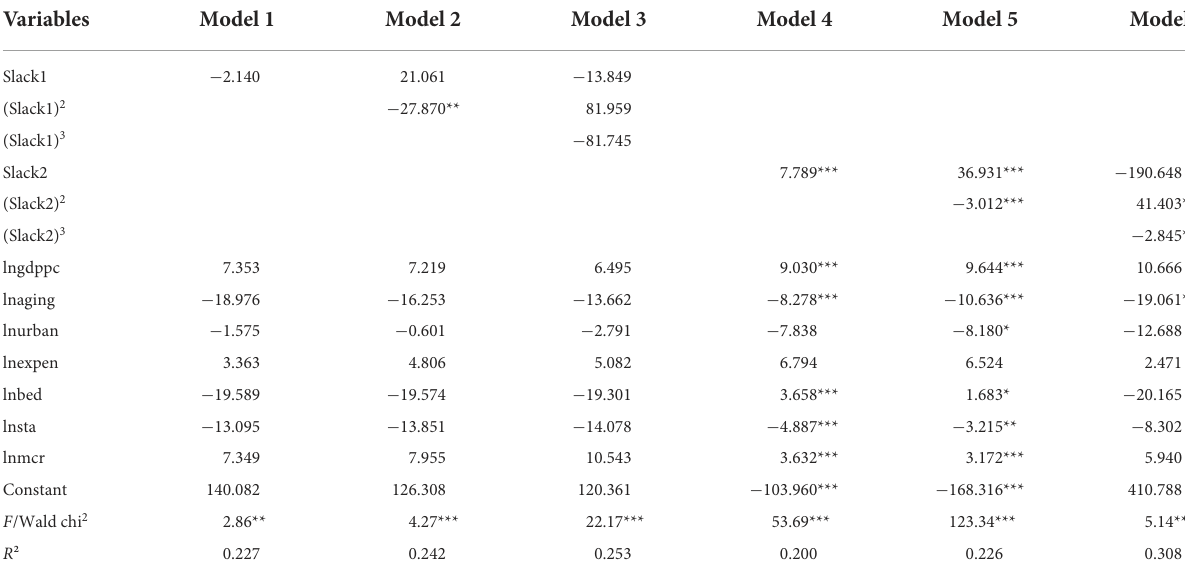
TABLE 2 Results from regression